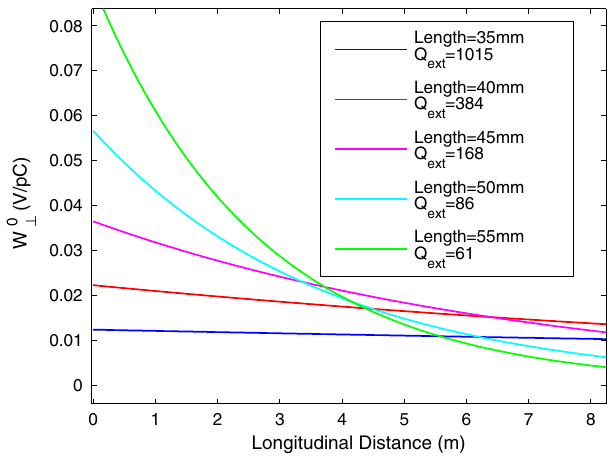
FIG. 9. Transverse wake potential W 0 ⊥ envelopes with different on-cell damper coupling